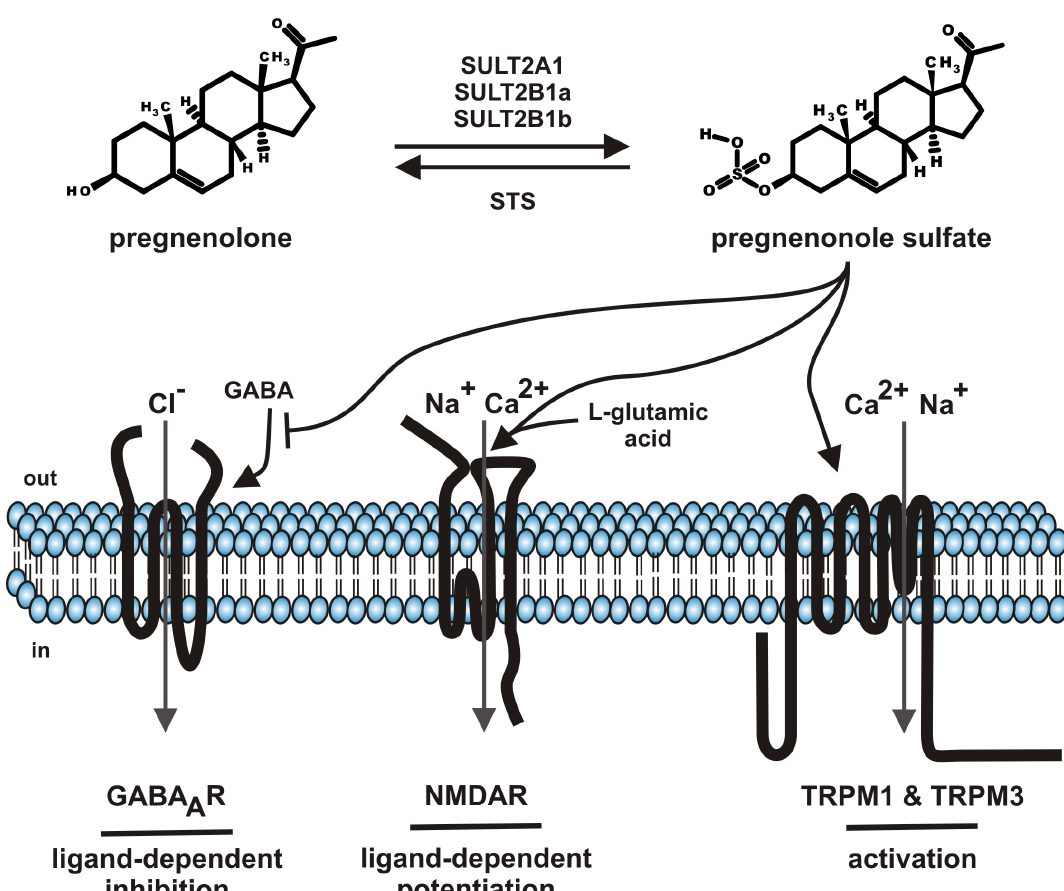
Figure 1. Summary of pregnenolone sulfate synthesis, metabolism and